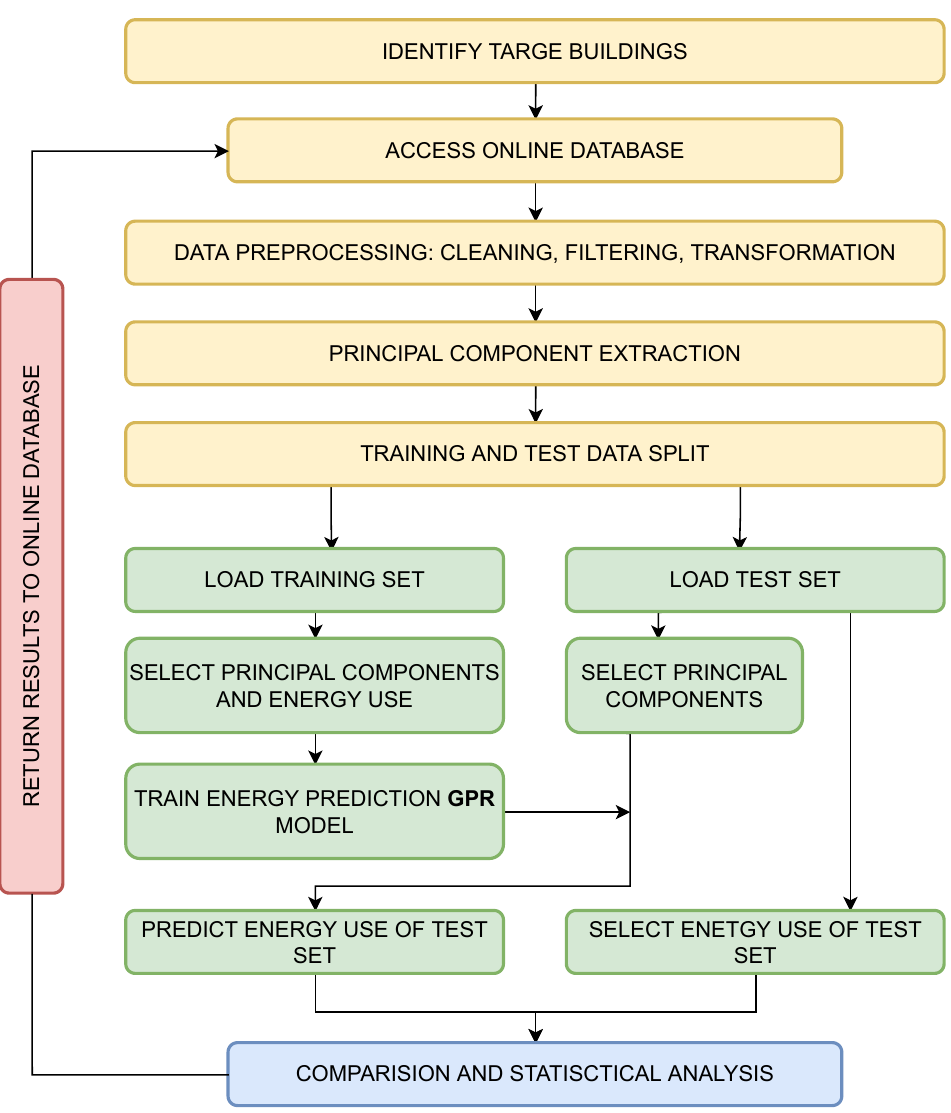
Figure 3. The problem of predicting energy usage in different kinds of building starts with identifying a target building. In the mentioned case, these are mostly offices and malls (buildings where people come regularly). The first component (yellow blocks) focuses on data processing. The algorithm connects to the base of the gathered data (historical data for training, real-time data for tests) and makes necessary operations like cleaning, filtering and component extraction. At the end, data are divided into testing and training sets. The green part of the scheme relates to the use of the GP model. Data are then used to train and test GP and at the end, to use it as a prediction of energy use. Results are then analysed and evaluated with several things, such as RMSE. The final prediction and other gathered results and analysis are finally saved to the database